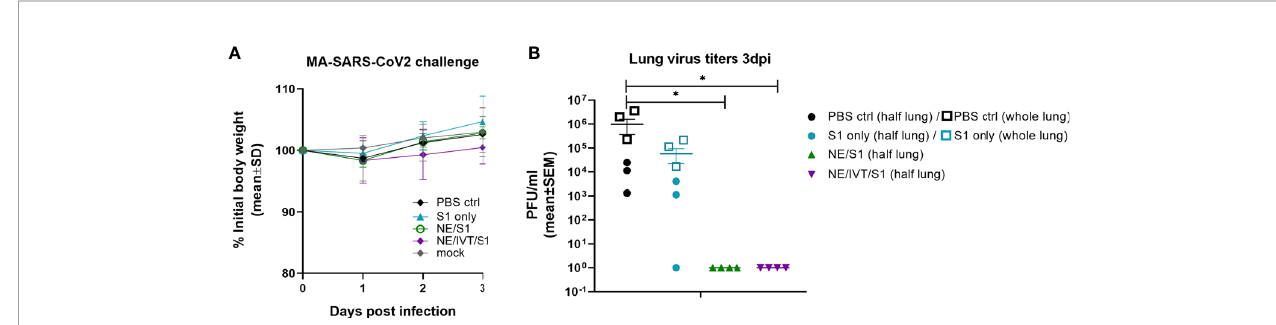
FIGURE 5 | Protection offered by passive transfer of serum from vaccinated mice against heterologous challenge with MA-SARS-CoV-2. Naïve C57Bl/6 mice (n=3- 4/group) each received 150 m L of pooled serum through the intraperitoneal route from donor mice given three IN immunizations of S1, NE/S1, or NE/IVT/S1. 2 h after serum transfer, mice were challenged IN with 10 4 PFU of MA-SARS-CoV-2. (A) Body weight loss was measured over three days, and at 3 dpi (B) lung virus titers were determined in homogenate from one lobe of the isolated lungs by plaque assay (solid symbols). Passive transfer/challenge was repeated for the PBS control and S1 sera for veri fi cation, and virus titers were measured in whole lung in the replicated experiment (open square symbols). (*p < 0.05 by Mann-Whitney U test assessed for half lung data